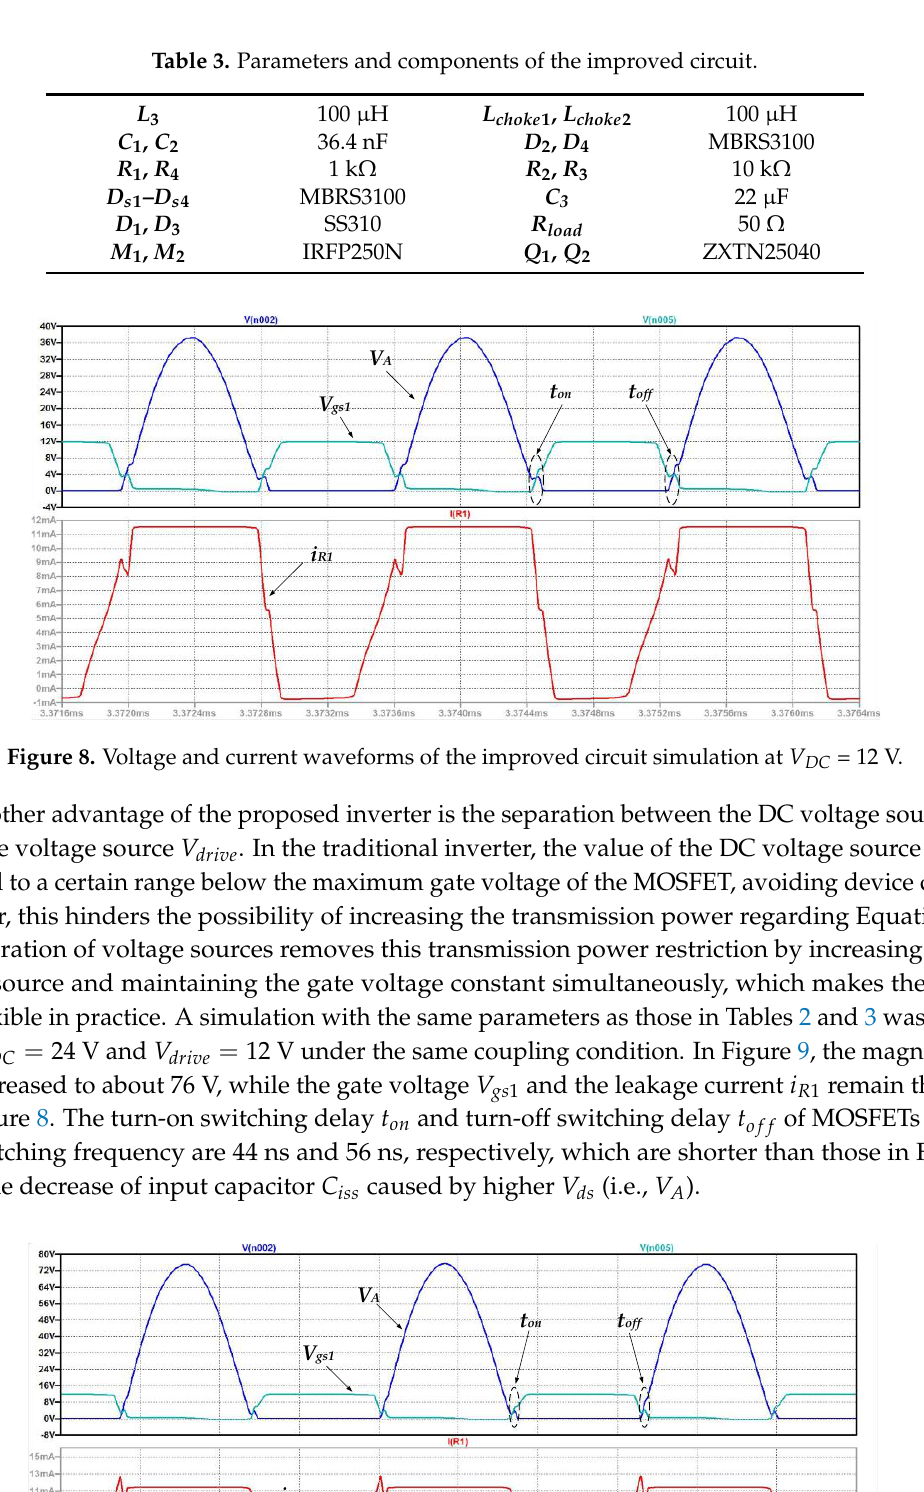
Figure 7. The schematic of an improved autonomous current-fed push-pull IPT system. Table 3. Parameters and components of the improved circuit.